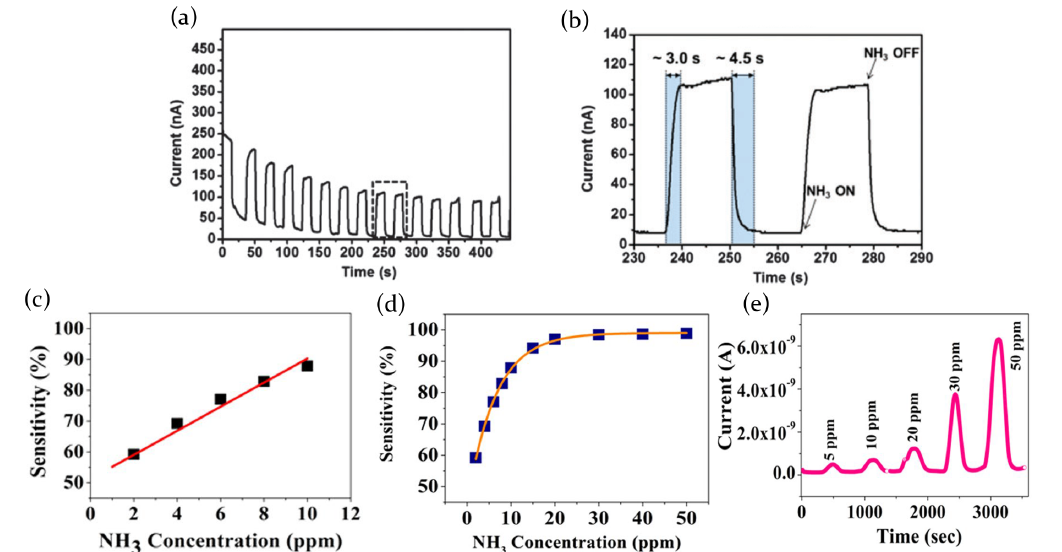
Figure 16. ( a ) I–t curve for a MAPbI 3 perovskite film for NH 3 on/off cycles; the current plot shows an initial overall gradual decrease due to the phase transformation, then settling at a constant level. ( b ) Expanded view of the on and off switches of the gas, with the corresponding response and recovery times (blue shade). Used with permission from the Royal Society of Chemistry [84]. Copyright © 2015. Permission conveyed through Copyright Clearance Center, Inc. ( c ) Linear dependence of the sensitivity as a function of NH 3 concentration in a 1–10 ppm range for a MAPbI 3 film deposited on a paper substrate; ( d ) sensitivity as a function of higher values, ammonia concentration 1–50 ppm ; ( e ) current modulation resulting from NH 3 on/off switches at increasing gas concentration. Adapted with permission from [81] under the terms of the Creative Commons Attribution 4.0 International License. Copyright © 2019, Springer